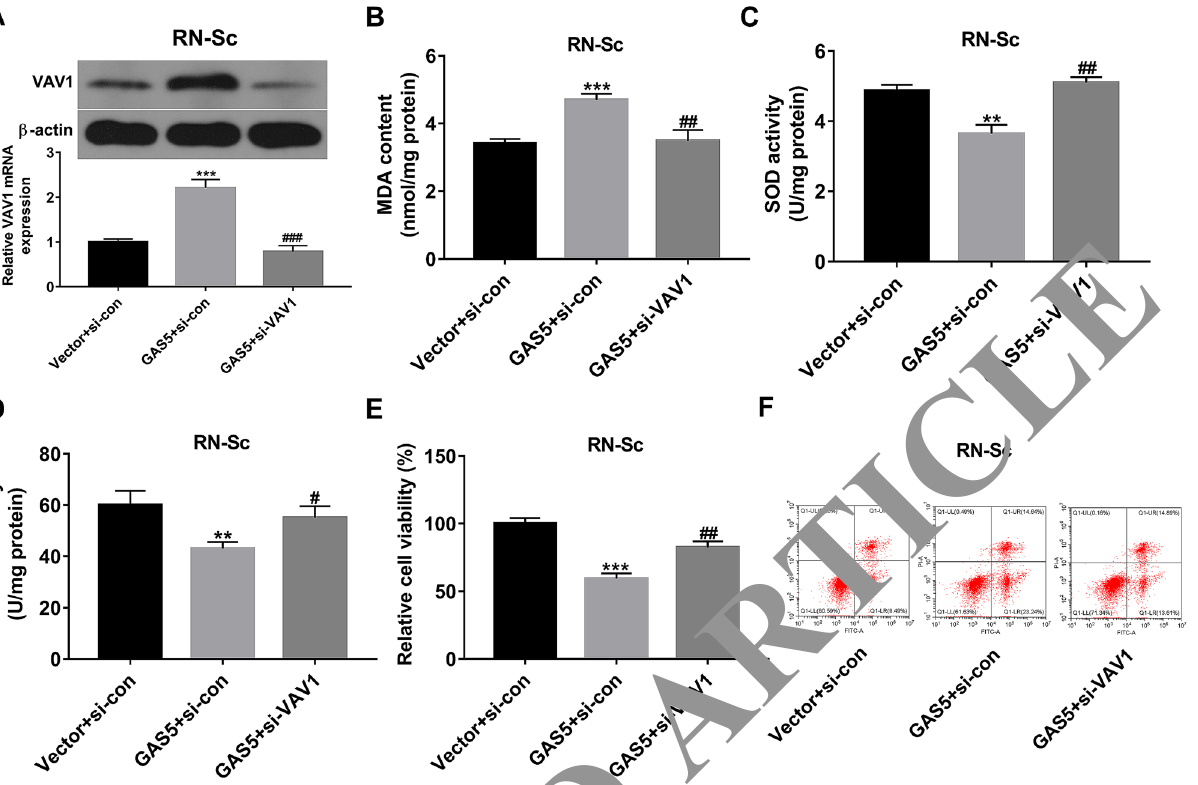
Figure 6. VAV1 loss alleviated GAS5-induced oxidative stress and cell injury in OGD-treated RN-Sc cells. ( A – F ) RN-Sc cells were transfected with Vector + si-con, GAS5 + si-con or GAS5 + si-VAV1. At 24 h post transfection, cells were underwent with or without OGD/R treatment, followed by the measurement of VAV1 mRNA and protein expression ( A ), MDA content ( B ), SOD activity ( C ), GSH-Px activity ( D ), cell viability ( E ) and cell apoptotic rate ( F ) at 12 h after reoxygenation. ** P < 0.01, *** P < 0.001, # P < 0.05, ## P < 0.01, ### P <